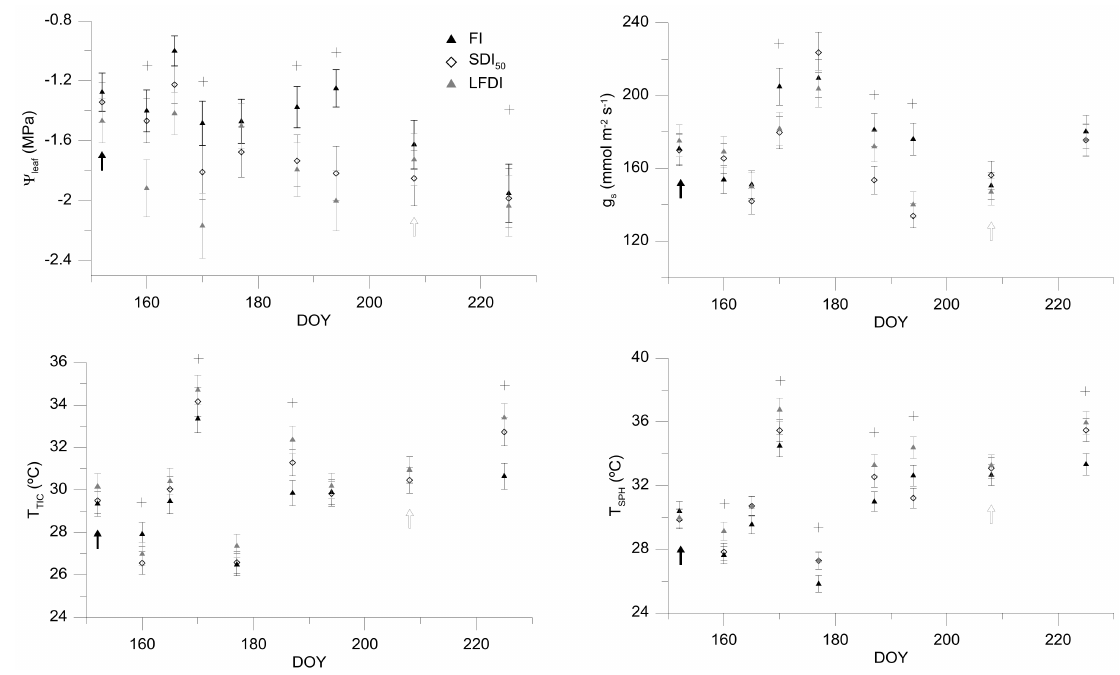
Figure 4. Temporal dynamics of leaf water potential ( Ψ leaf ); stomatal conductance (g s ), canopy temperature readings with a Flir SC660 camera (T TIC ); and with a Flir One camera connected to a smartphone (T SPH ). FI, Full irrigated treatment at 100% ET C ; SDI 50 , sustained deficit irrigation treatment at 50% ET C ; LFDI, low-frequency deficit irrigation, irrigated in terms of Ψ leaf values. Black arrows correspond to the beginning of water stress period, white arrows to the moment in which irrigation is suppressed in all of the treatments (seven days before the harvesting). The asterisks show those moments in which significant differences between FI and stressed treatments were reached. Vertical lines represent the standard error for each